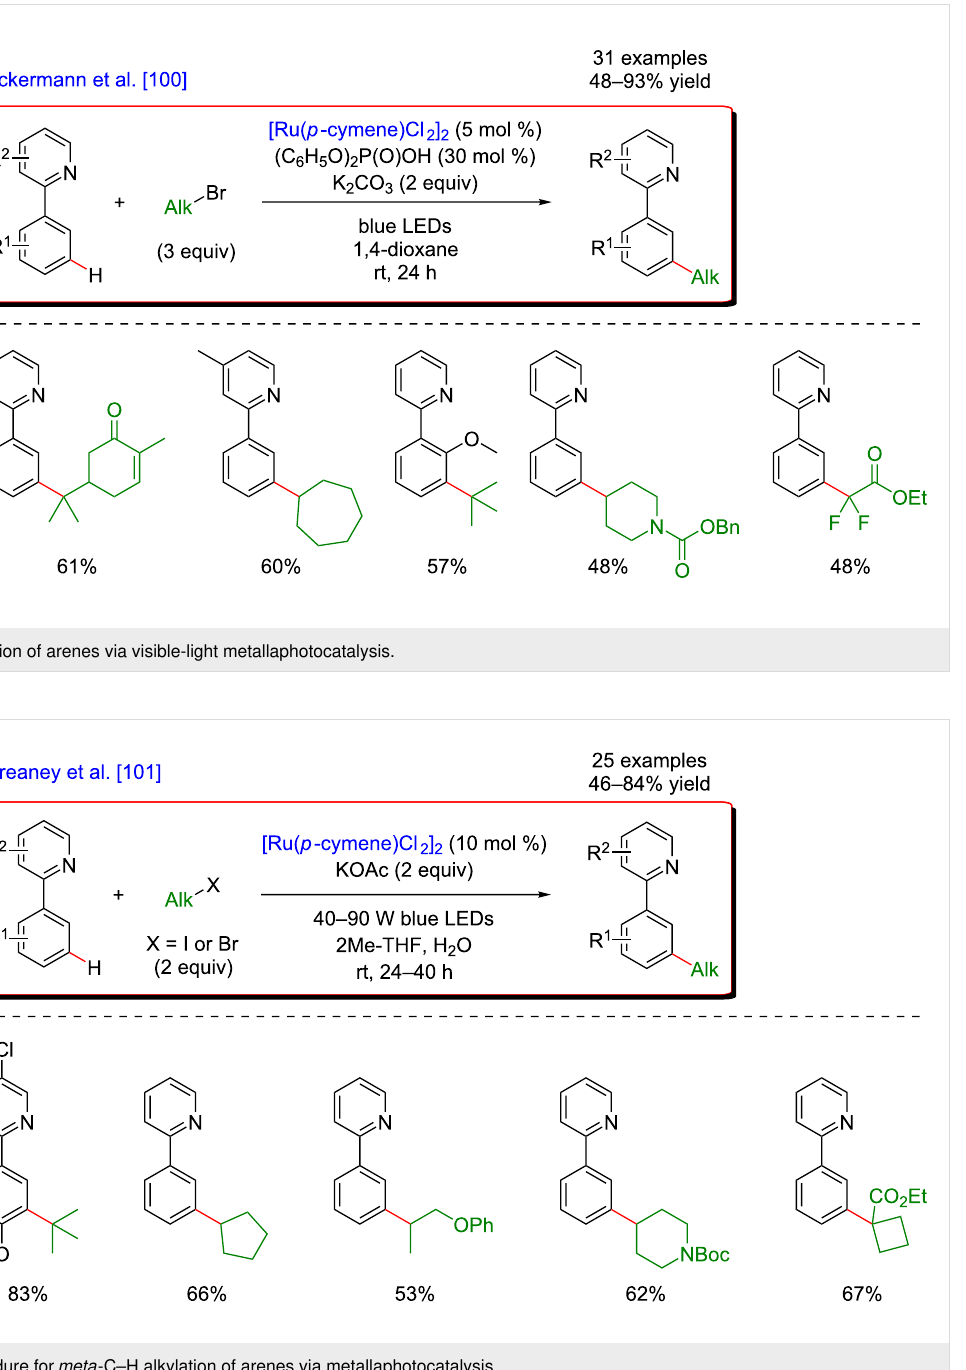
A few months later, Baslé et al. exploited the same concept of merging C–H activation and photocatalysis while using a single metal catalyst. In this case, an original Rh–NHC complex was used for the ortho- directed C–H borylation of phenylpyridine substrates (Figure 40) [102]. As previously, the irradiation with visible light allowed performing this challenging borylation under mild reaction conditions, thus delivering, after oxidation